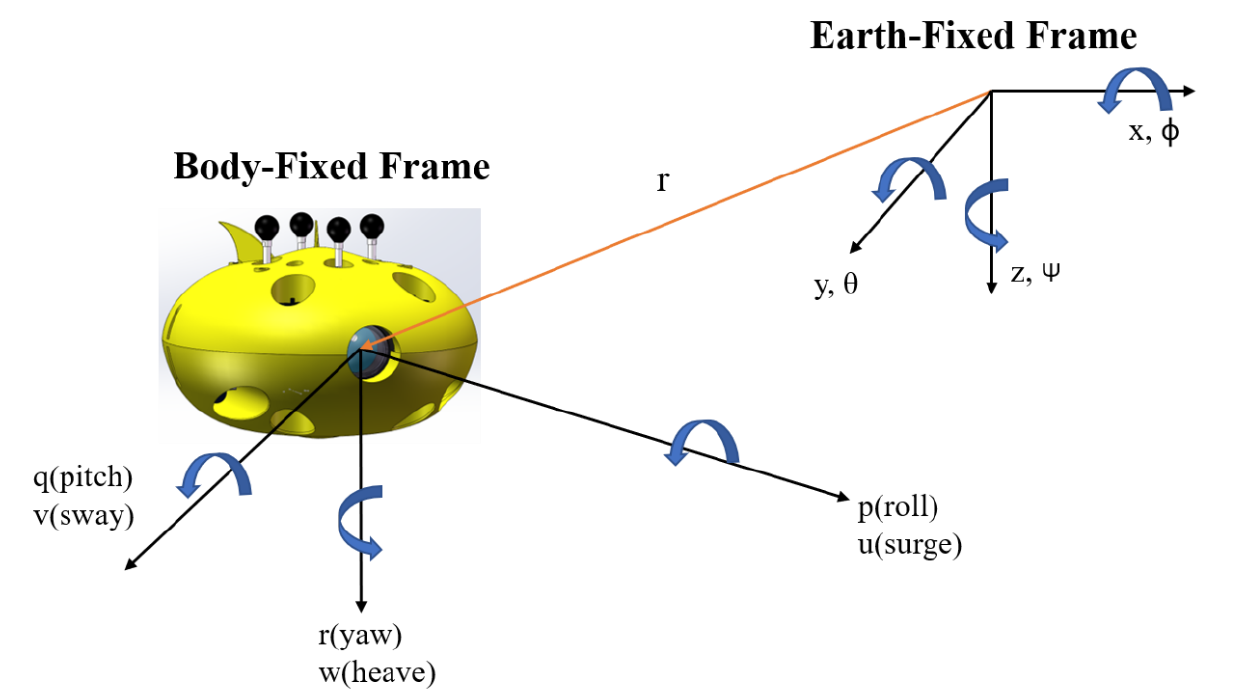
Figure 9. The inertial and body frame of AUH.